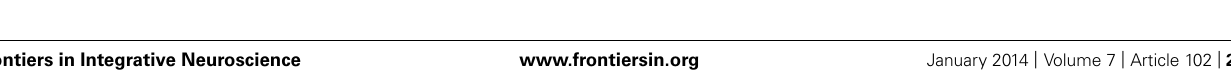
Frontiers in Integrative